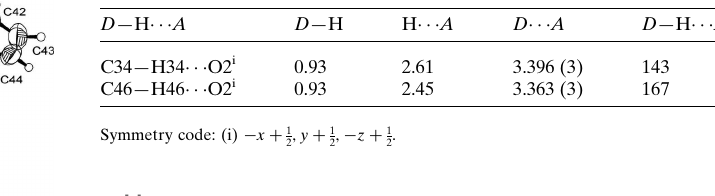
Table 2 Experimental details.